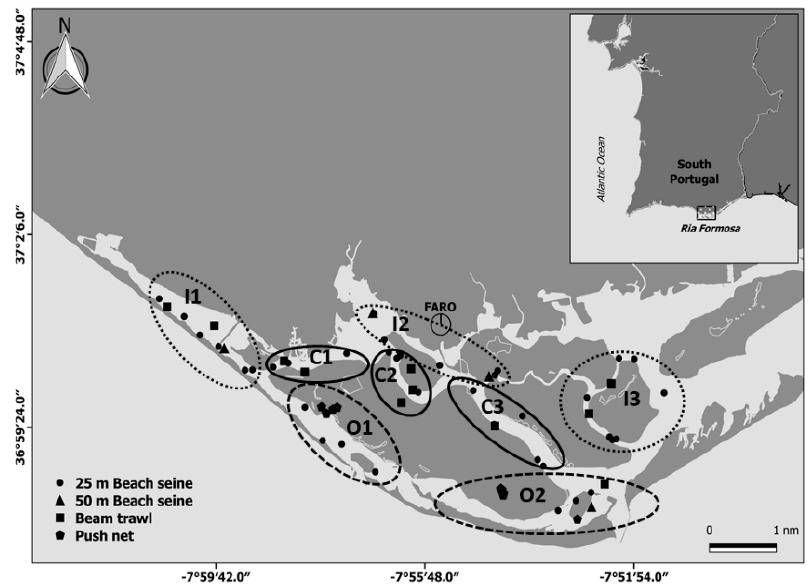
Figure 1. Distribution of sampling stations for the four sampling gears used to survey fish assemblages in the Ria Formosa coastal lagoon (South Portugal), with the three areas (Interior: I1, I2, I3; Main and secondary channels: C1, C2, C3; Outer, strong coastal influence: O1, O2). nm = nautical